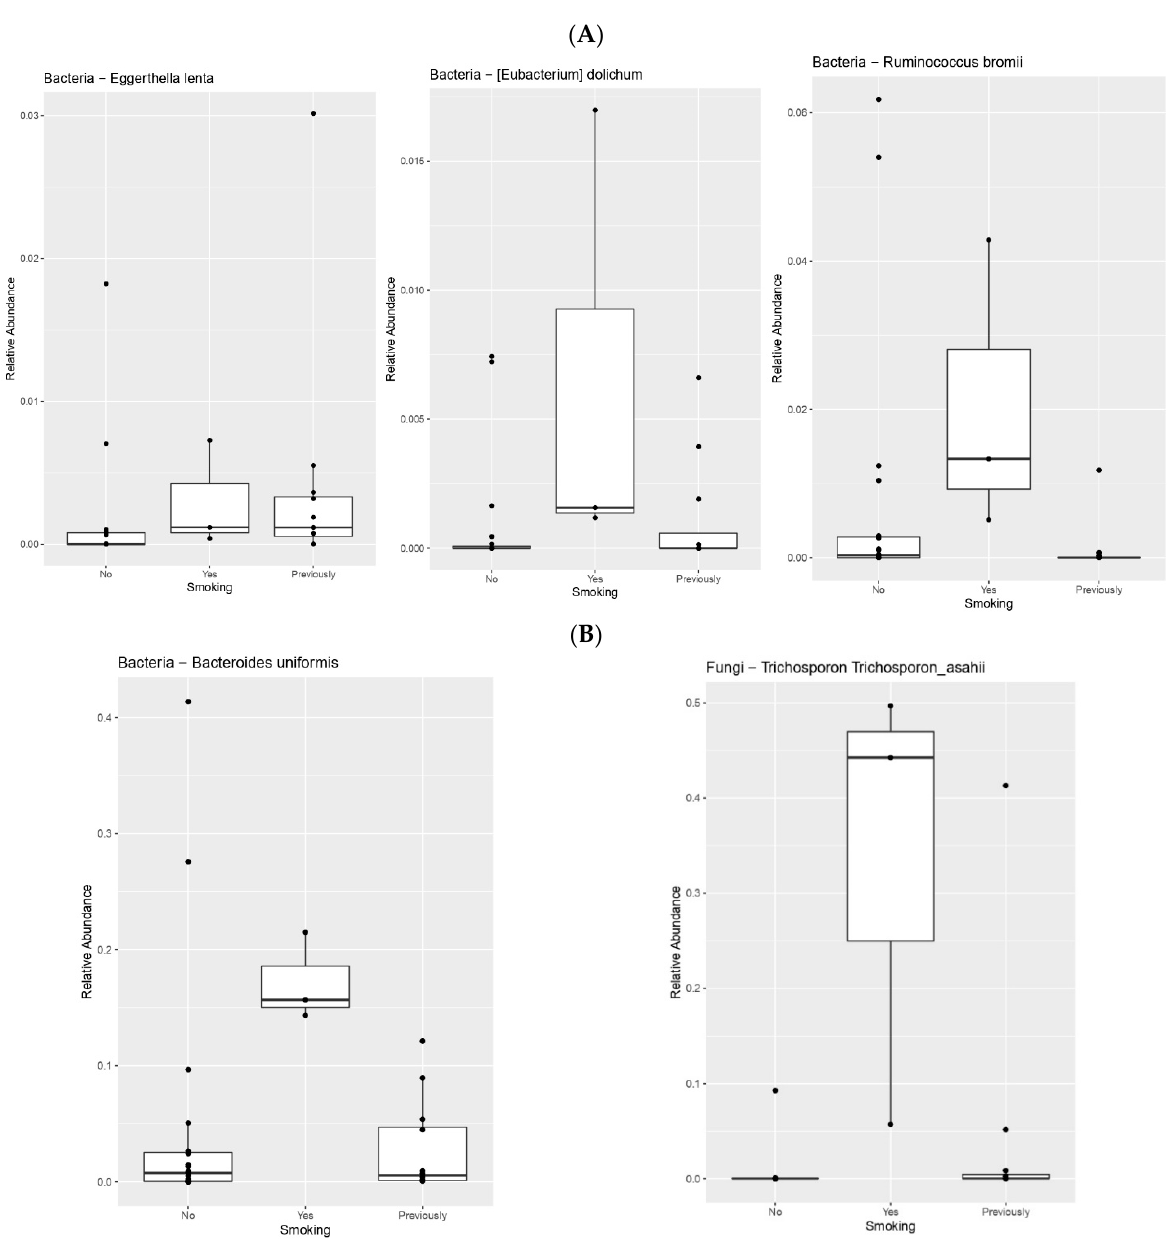
Figure 3. ( A ) Smokers had significantly more anaerobic, Gram-positive species ( Eggerthella lenta , Eubacterium dolichum , and Ruminococcus bromii ) ( p = 0.03, 0.046, and 0.01, respectively) compared to non-smokers. ( B ) Smokers had significantly more anaerobic Gram-negative bacteria ( Bacteroides uniformis ) ( p = 0.04), and certain fungi ( Trichosporon asahii ) ( p = 0.005) compared to non-smokers.